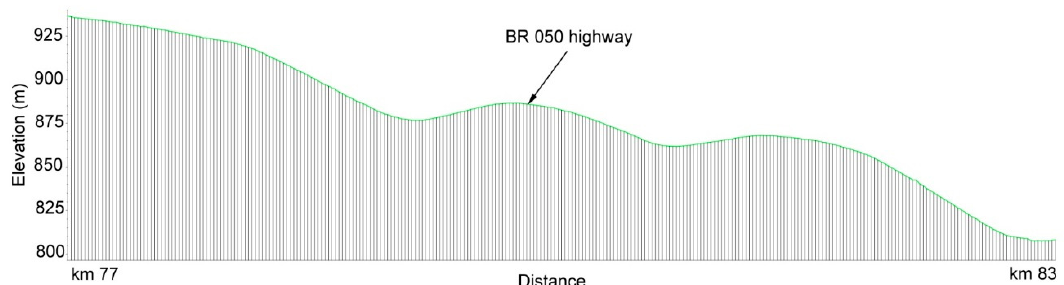
Figure 5. Elevation profile of the BR 050 highway segment involved in a large number of road accidents. This segment is located between km 77 and km 83 of the highway, as illustrated in Figure 1. The elevation profile was generated using the Google Earth software. The accidents are mostly caused by fast-speed traffic in a relatively steep-slope road.